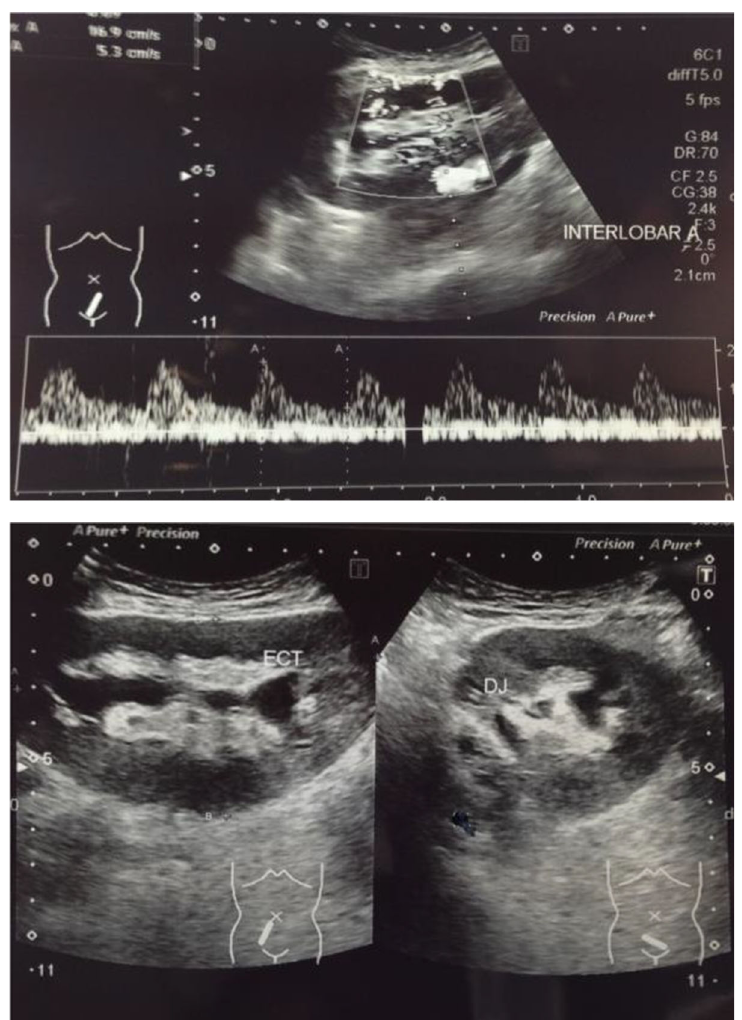
Figure 5. Ultrasound evaluation results of recipient after double-J stent insertion.